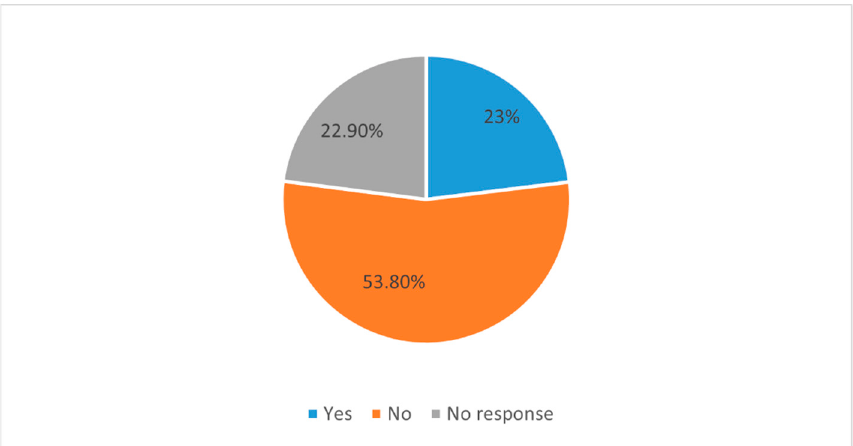
Figure 5. Pie chart shows distribution of respondents based on their self-reported completion of the undergraduate neurosurgery rotation.